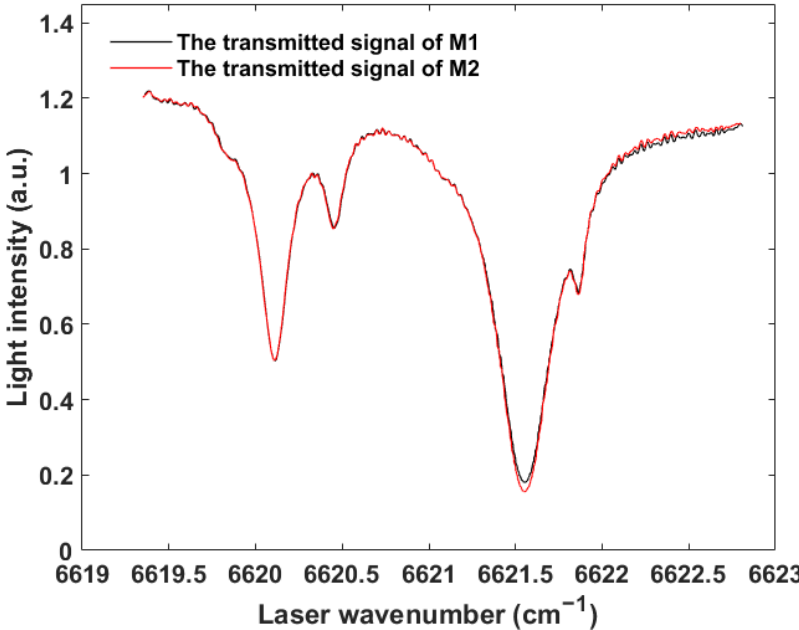
Figure 5. The OF-CEAS cavity transmitted signal optically glued onto a wedge mirror. The OF-CEAS cavity transmitted signal of M1 (black). The OF-CEAS cavity transmitted signal of M2 (red).